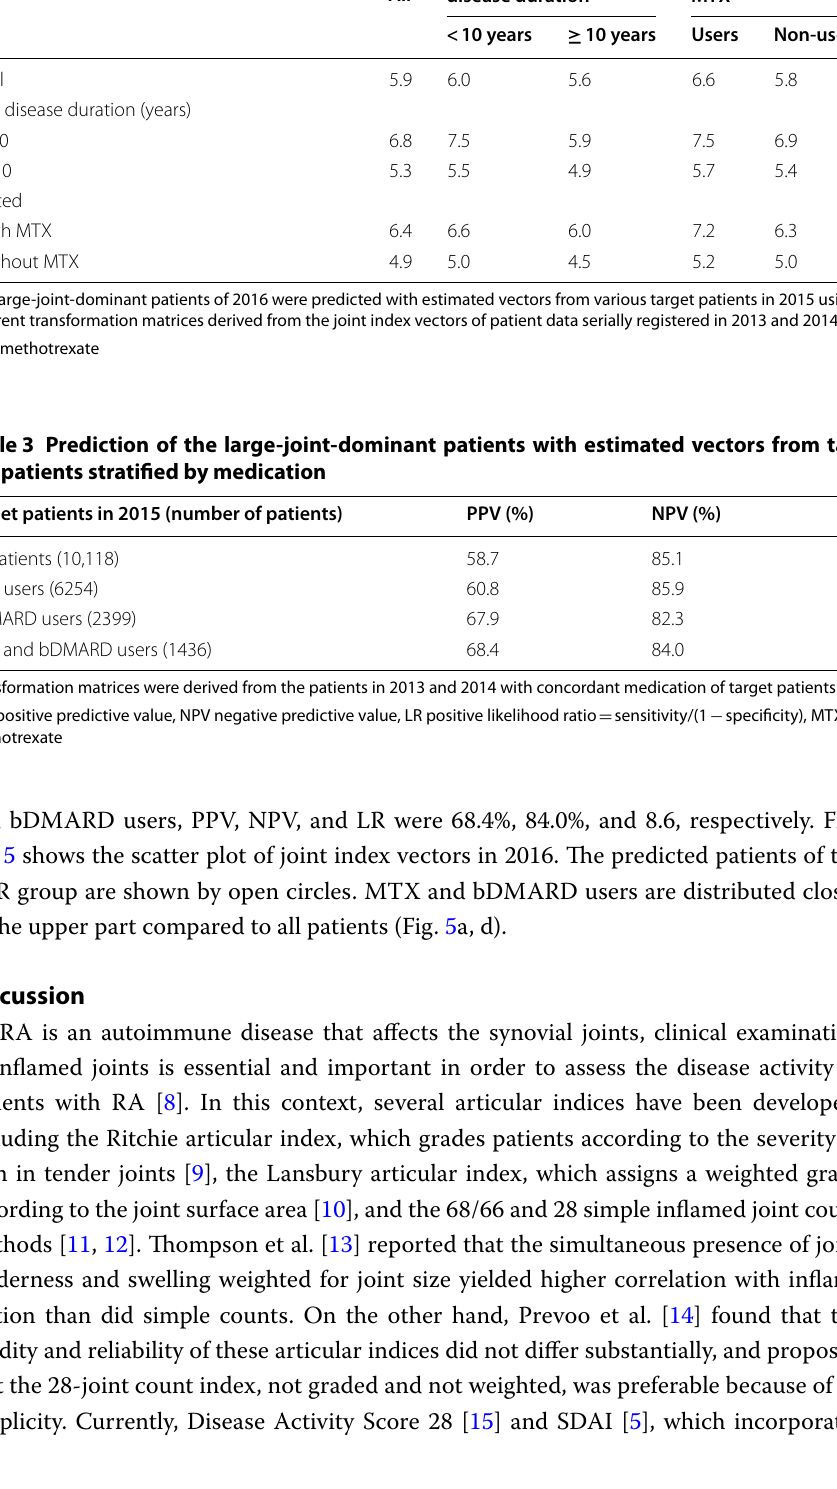
Table 2 Positive likelihood ratio in predicting the large-joint-dominant patients Transformation matrix derived from patients Target patients in 2015